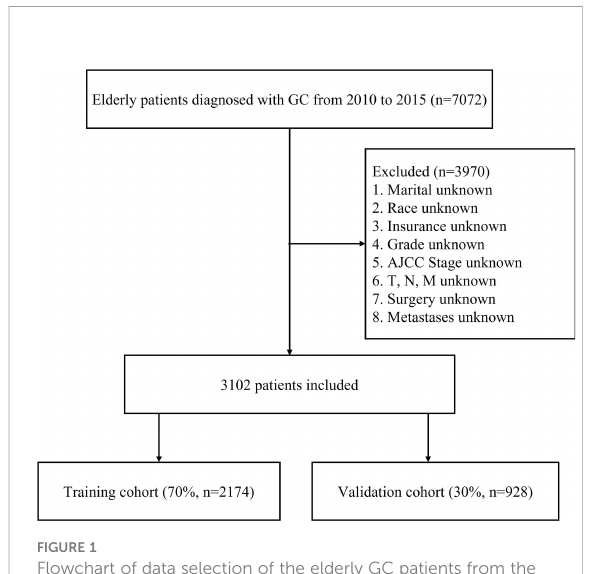
FIGURE 1 Flowchart of data selection of the elderly GC patients from the SEER